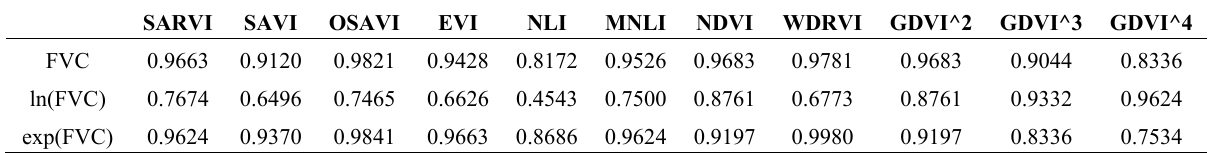
Table 8. Pearson correlation coefficients (R 2 ) between VIs/Generalized Difference Vegetation Index (GDVI) and fractional vegetation cover (FVC) from Landsat